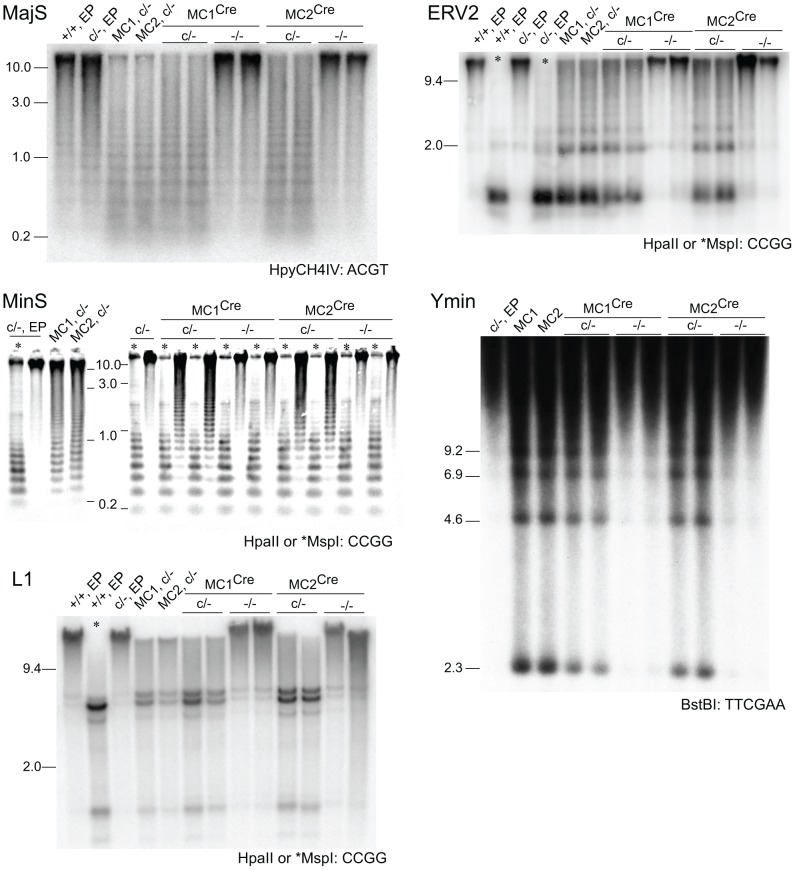
Rebound DNA methylation at repetitive sequences after Dicer1 ablation.Southern blots. MC1Cre and MC2Cre are sublines derived from Cre transfection of line MC1 and MC2 respectively. Other details are as provided in the legends to previous figures.